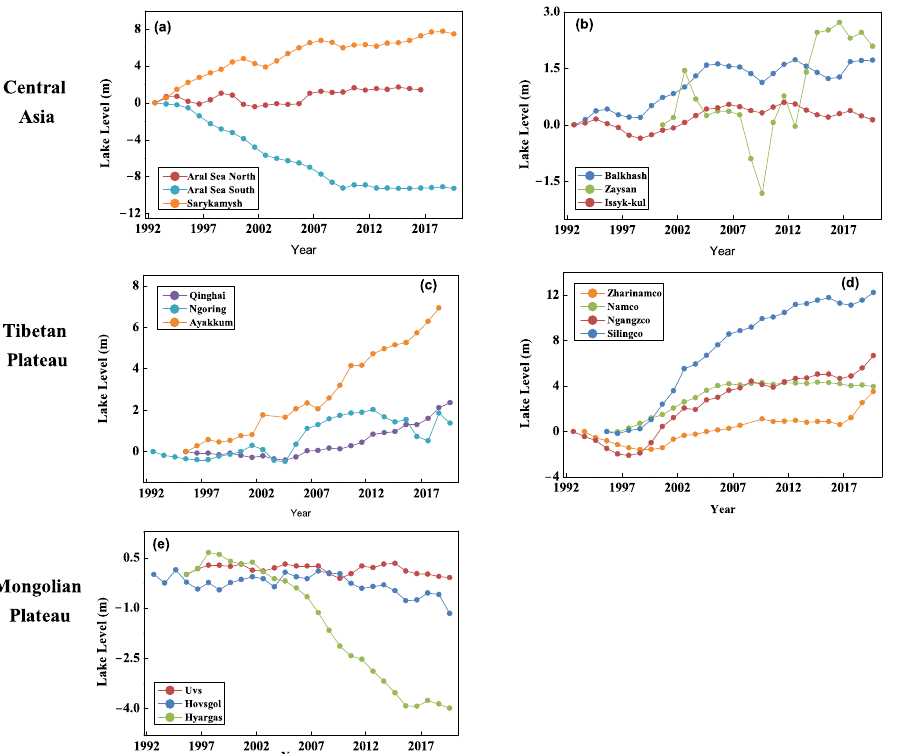
Figure 3. The annual change of water level in lakes located at Central Asia ( a , b ), Tibetan Plateau ( c , d ), and Mongolian Plateau ( e ).